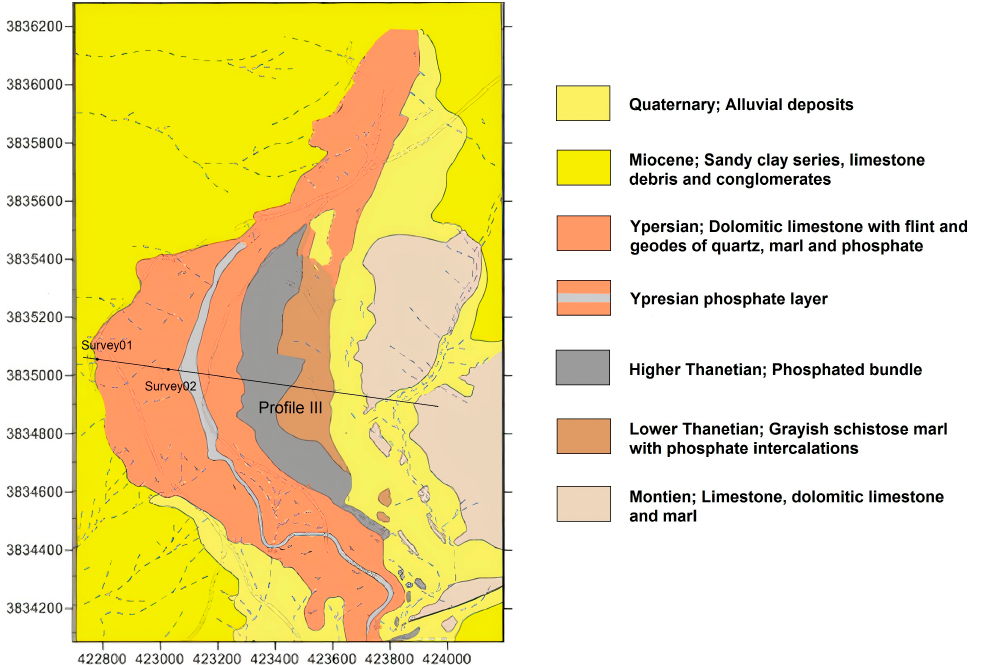
Minerals 2021 , 11 , x FOR PEER REVIEW Figure 1. Geological map of the structure of the Bled El Hadba phosphate deposit in Algeria.